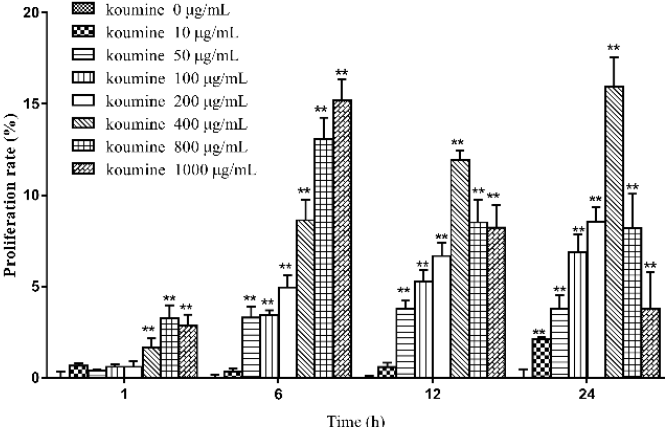
Figure 2. Effect of koumine on the viability of IPEC-J2 cells (mean ± s.d., n = 5). Legend: compared with the control group; * and ** indicate level of significance at p < 0.05 and p < 0.01, respectively, compared with the oxidative stress model group.